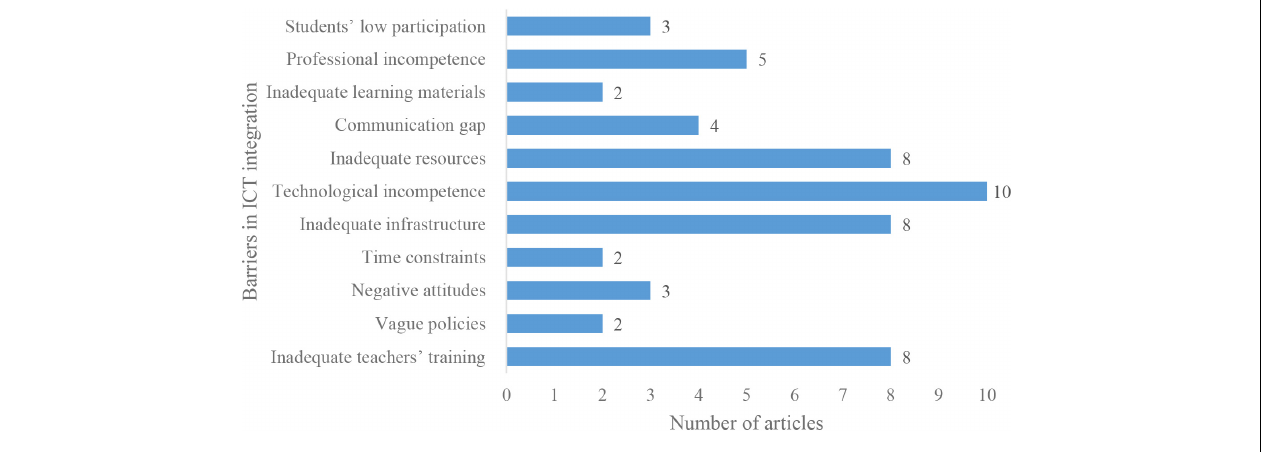
FIGURE 5 | Barriers in information and communication technology (ICT)